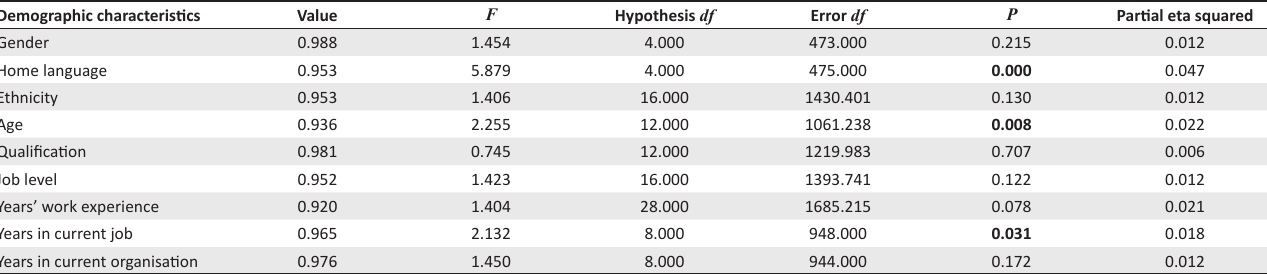
TABLE 5: Multivariate analysis of variance analyses – Service orientation and execution and demographic